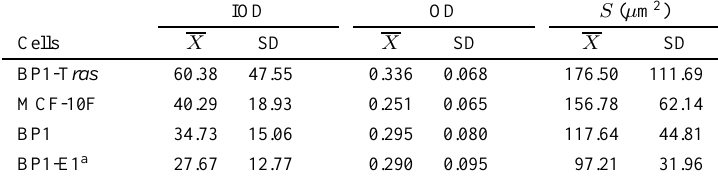
Video nuclear image parameters for Feulgen-stained MCF-10F cell lines ( n = 200)